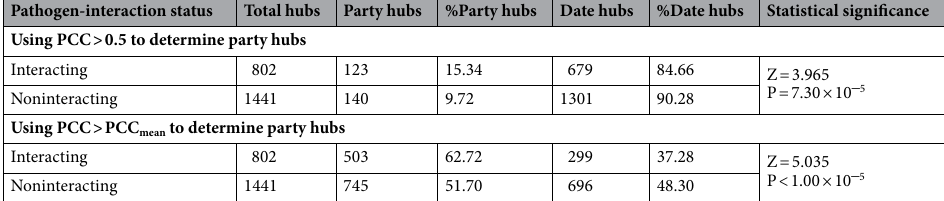
Table 2. Proportion of party-hubs and date-hubs in pathogenic bacteria-interacting and non-interacting human proteins.